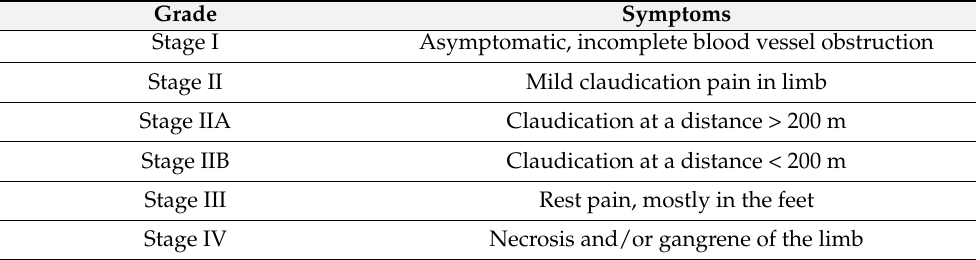
Table 1. Fontaine classification.